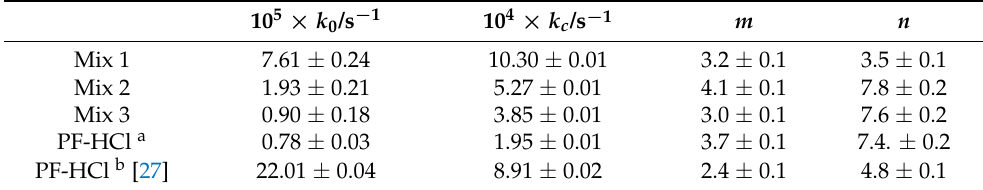
Table 1. Relevant kinetic parameters for the J-aggregation of H 2 TPPS 44 − ( k 0 , k c , m , and n ) as functions of different mixing order protocols. Parameters were developed by adopting a porphyrin first (PF) mixing protocol by using HCl at different concentrations.